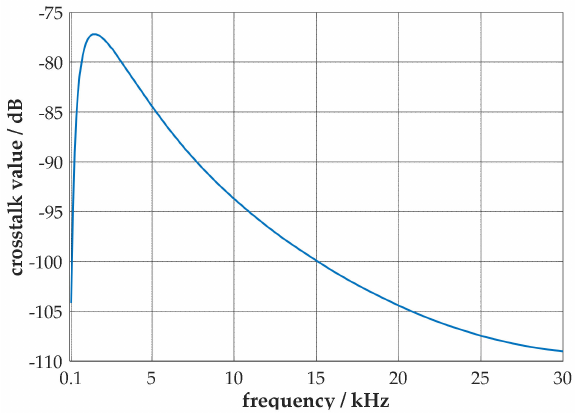
Figure 9. The changing pattern of the far − end crosstalk value versus